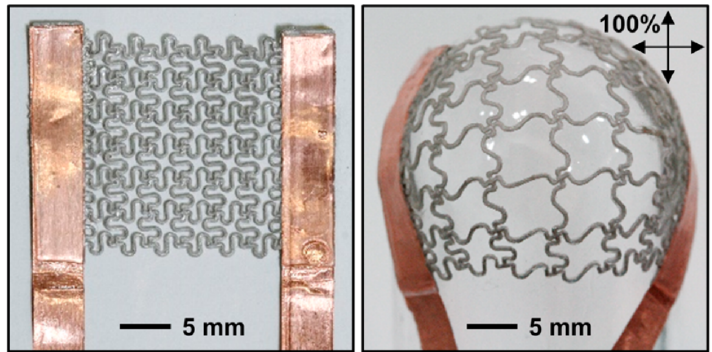
Figure 2. Optical image of a mesh heater ( left ) before and ( right ) after biaxial stretching up to 100%. Reprinted (adapted) with permission from [55]. Copyright 2015 American Chemical